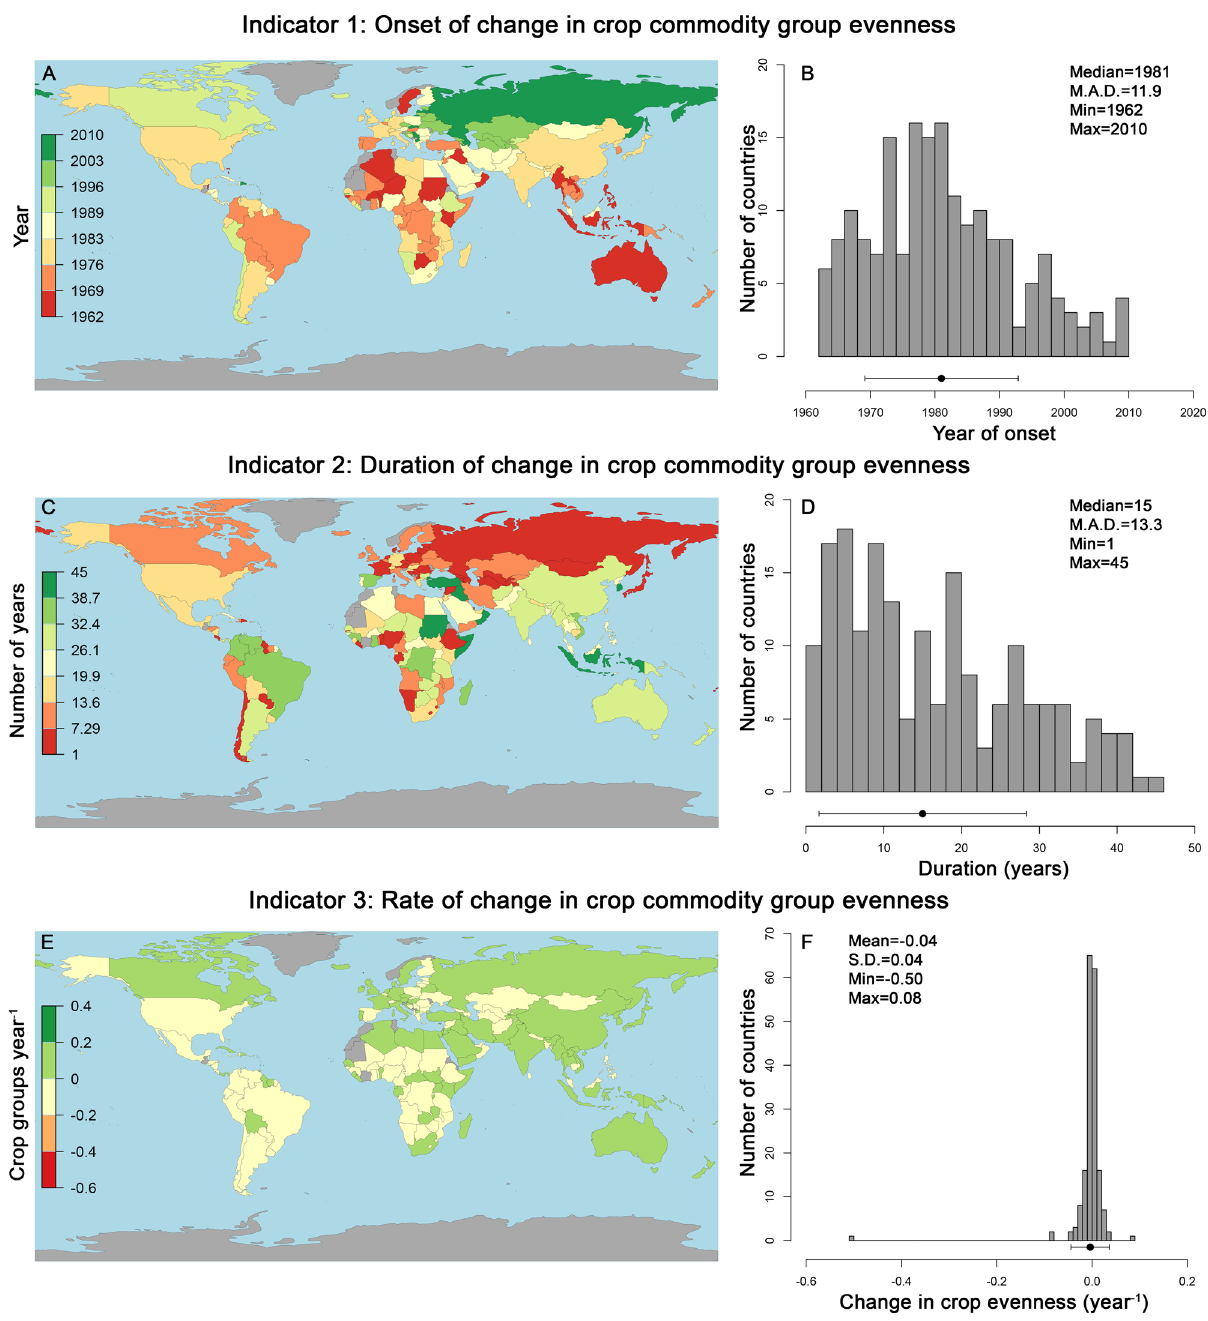
Figure 4. Maps and histograms of three indicators of crop commodity group evenness (Pielou’s evenness index ( J ′ )) across 185 countries. Values for all three indicators for each country were derived from piecewise linear models predicting J ′ as a function of year, where harvested area (in ha) was used to approximate group abundance. Countries coloured gray in the maps were those where either data was not available or the piecewise models failed to converge (denoted in Table S2). Histograms and associated descriptive statistics for each indicator are also presented, with means (± s.d.) or medians (± m.a.d.) denoted visually by the points and error bars below the histograms. All piecewise model parameters for each country are presented in Table S2. Maps were generated using the mapCountryData function in the rworldmap R package 30